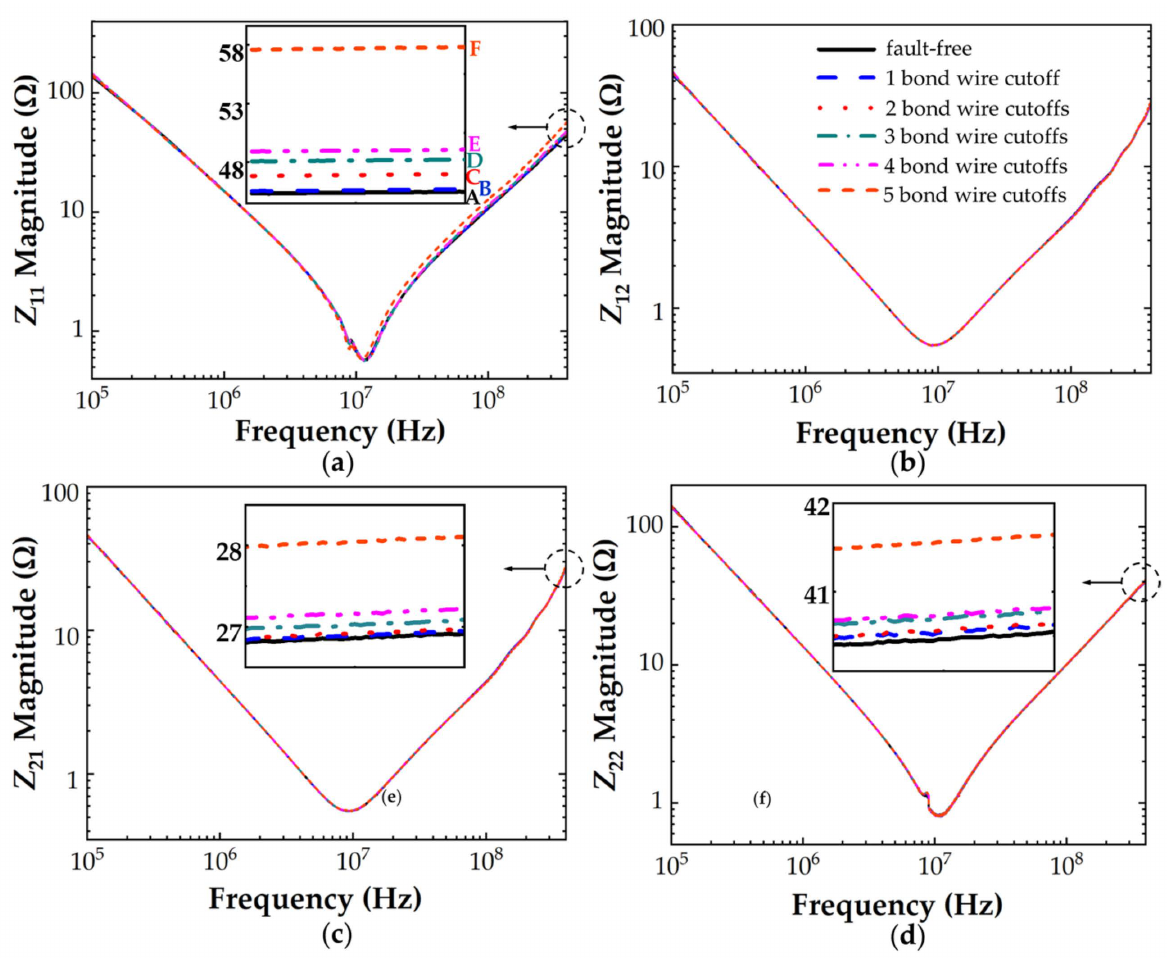
Figure 11. Z − parameters of IXFK32N100P with different cutoff numbers of bond wires (A = 45.03 Ω , B = 45.30 Ω , C = 46.62 Ω , D = 47.94 Ω , E = 48.84 Ω , F = 58.07 Ω ). ( a ) Z 11 , ( b ) Z 12 , ( c ) Z 21 , ( d ) Z 22